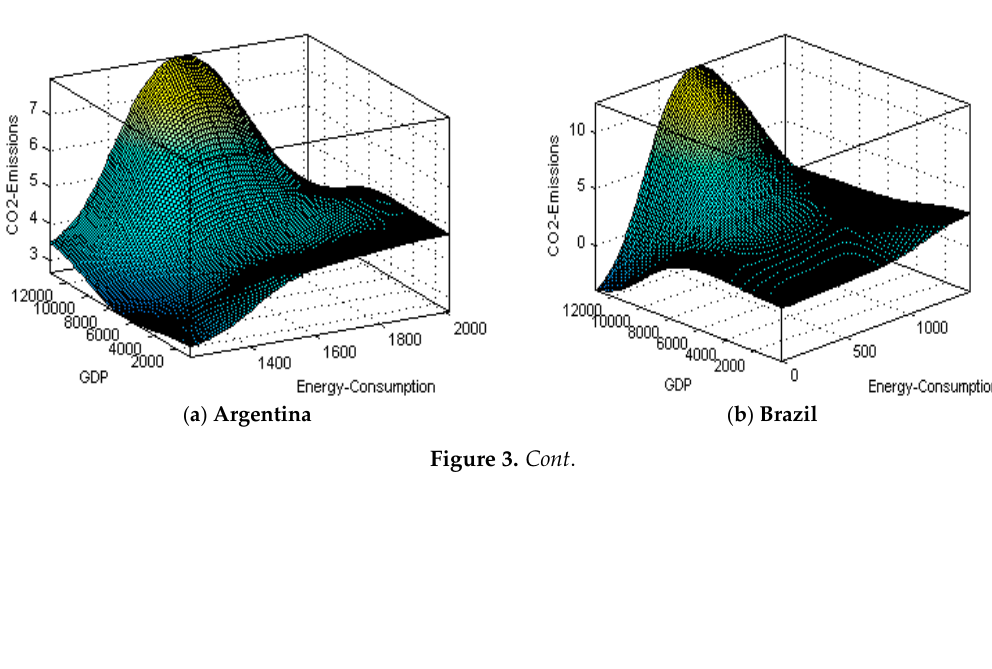
Table 1. Membership functions (MFs) information for the first cluster in predicting CO 2 for the United States. GDP: gross domestic product.